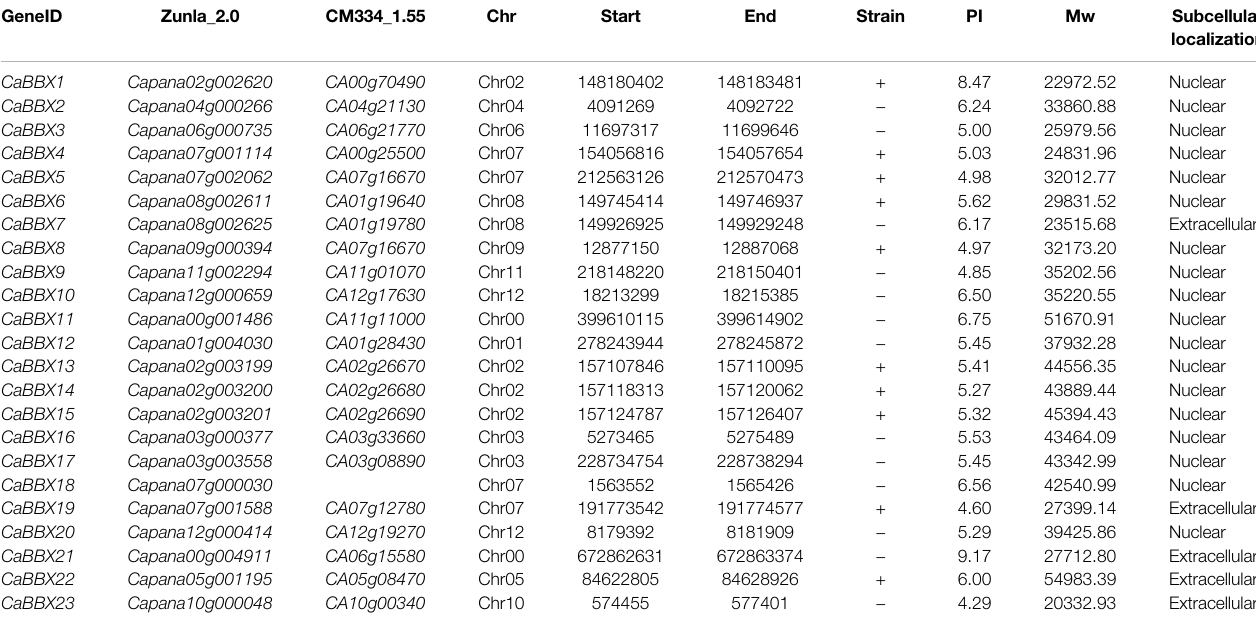
TABLE 1 | The information on the CaBBX gene family. GeneID